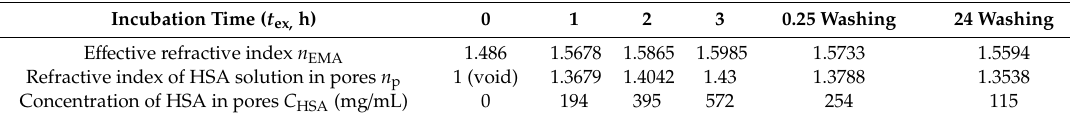
Table 1. Values of refractive indexes of pAAO layer and trapped HSA concentration calculated inside